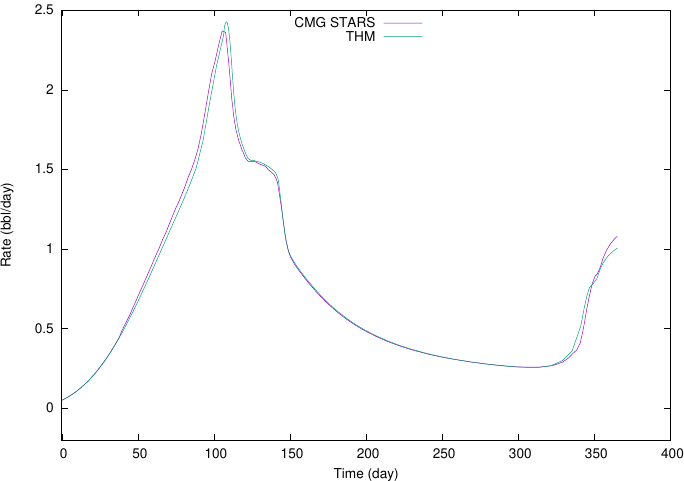
Figure 8. Example 1, total oil production rate